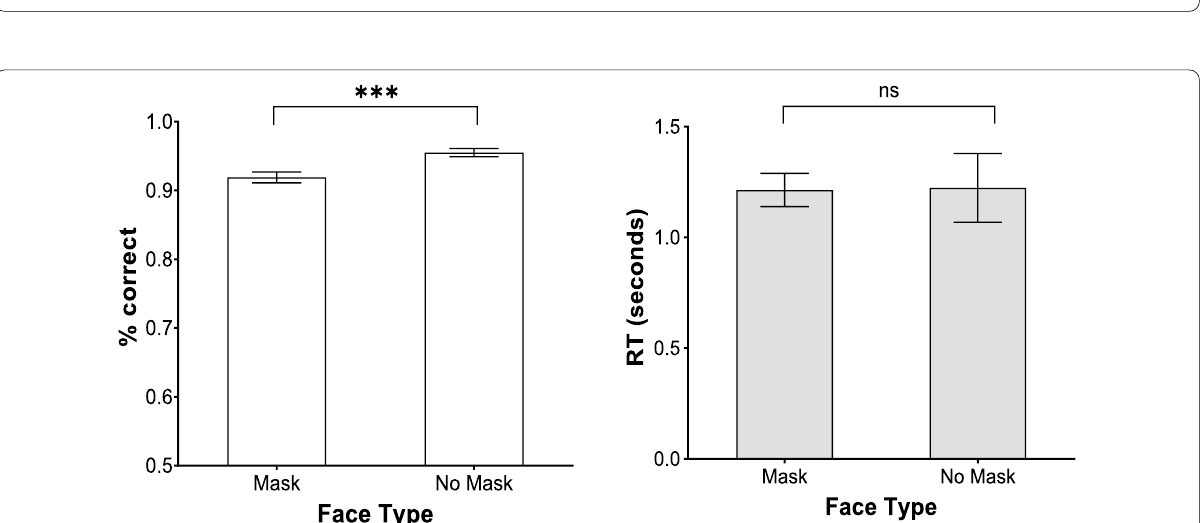
Fig. 7 The percentage correct and mean RT for masked and unmasked faces in the gender classification